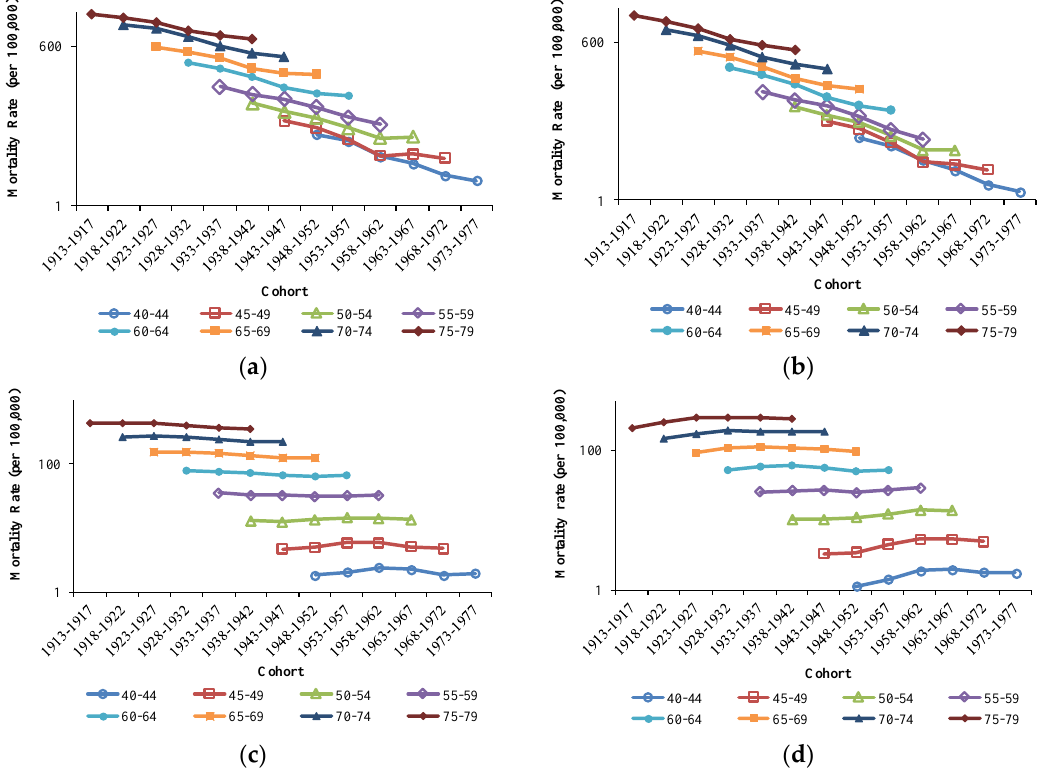
Figure 4. Cohort-based variation in age-specific COPD mortality in ( a ) Chinese males, ( b ) Chinese females, ( c ) U.S. males, and ( d ) U.S. females.